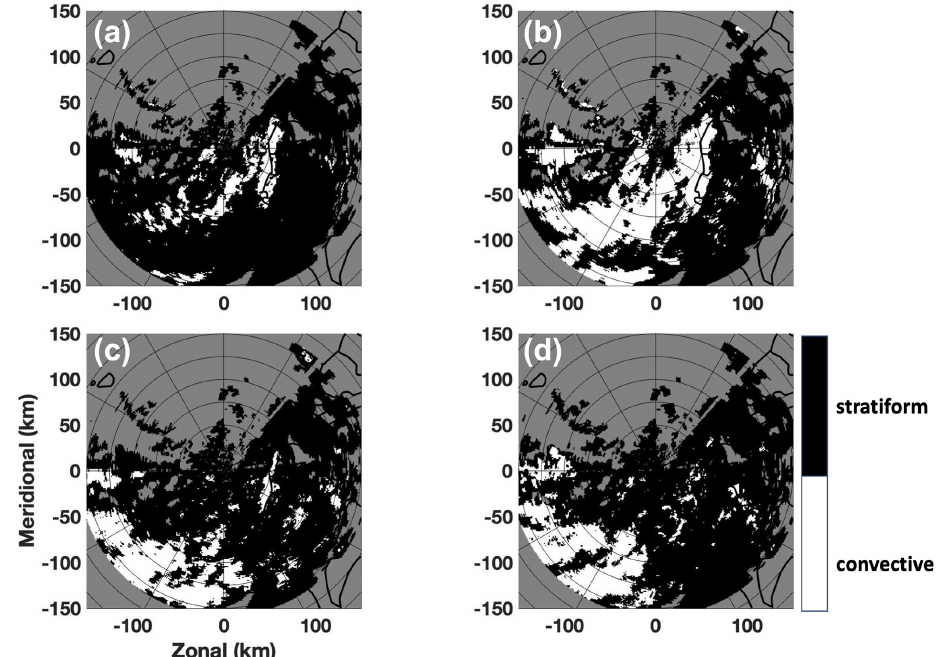
Figure 7. Similar to Fig. 5, results are from 06:50UTC.